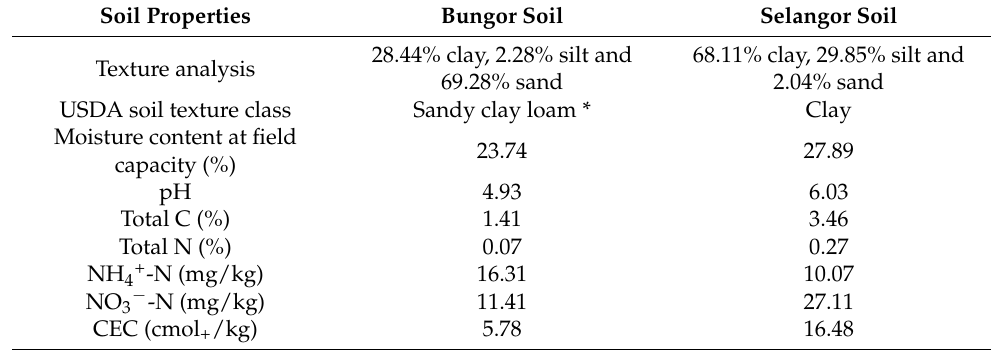
Table 1. Physicochemical properties of the